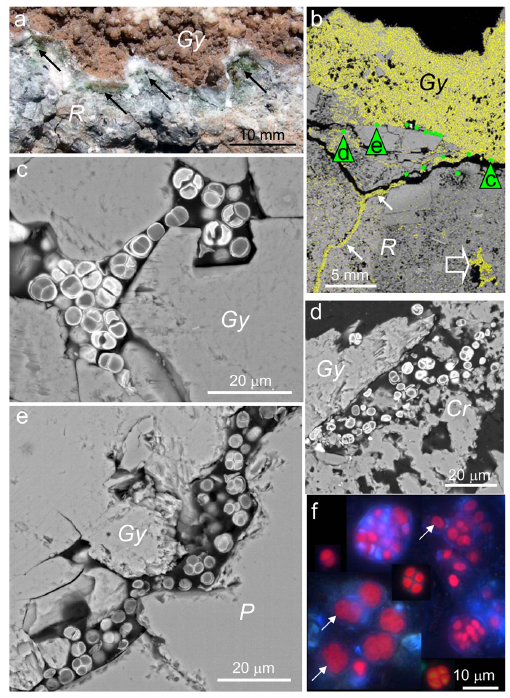
Fig. 1. Cross-sections of Tilo rhyolite rocks and their microbial colonisation. (a) In field macroscopic view of rhyolite ( R ) revealing green spots of chasmoendolithic microorganisms (black arrows) be- neath gypsum ( Gy ) deposits. (b) SEM-BSE low magnification im- age of transversal section showing gypsum deposit ( Gy ) covering rhyolite ( R ) rock. Gypsum deposit composition and gypsum occur- rence within fissures (white arrows) and pore (open arrow) were de- tected by superpositioned image (yellow spots) of Ca and S (belong- ing to CaSO 4 × 2H 2 O) and obtained by EDS elemental distribu- tion map. Green dots show places where chasmoendolithic microor- ganism cells where detected and arrowheads indicate position of the cells showed in following (c–e) SEM-BSE detailed images. (c) SEM-BSE image of cyanobacteria cell aggregates within fissures among gypsum ( Gy ) crystals. (d) SEM-BSE image of cyanobacteria cells within fissures among cristobalite ( Cr ) matrix. (e) SEM-BSE image of cyanobacteria cells within fissures between gypsum ( Gy ) and plagioclase ( P ) crystals. (f) Fluorescence microscopy image of cyanobacteria (red autofluorescence) cell aggregates isolated from rock; some of the cells reveal autofluorescent concentric thylakoids- like structures (white arrows). Blue signal is autofluorescence of dead cells or their relics and extracellular polymeric